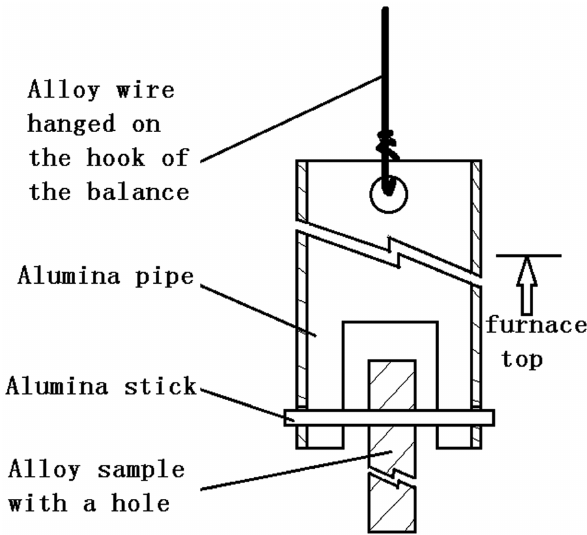
Figure 1: Device of connecting alloy sample to the balance in the oxidation